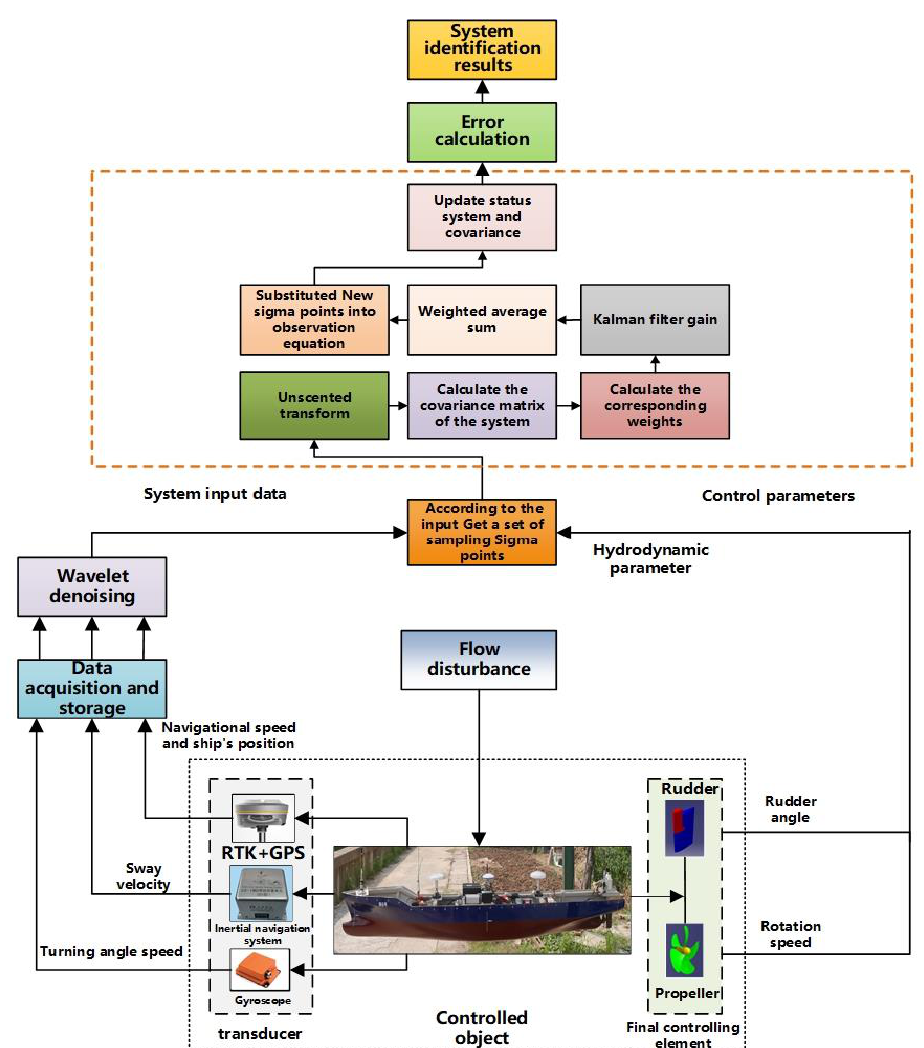
Figure 2. Principle of the self-propelled model test and online identification.